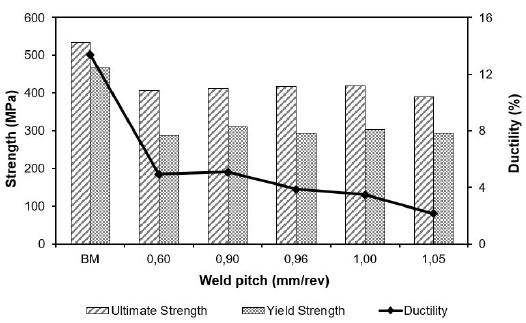
Figure 11. Tensile properties for different welding conditions and BM, showing yield strength (YS), ultimate tensile strength (US) and elongation